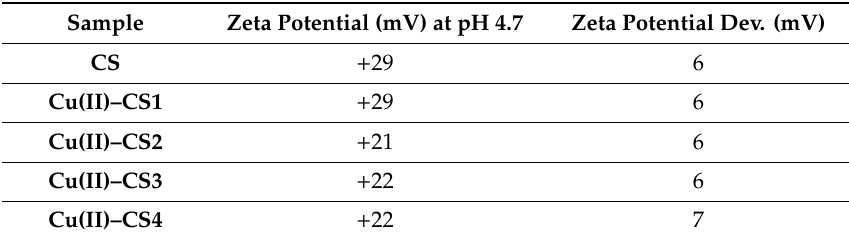
Table 1. Zeta potential and electrophoretic mobility of the suspensions used for electrophoretic deposition